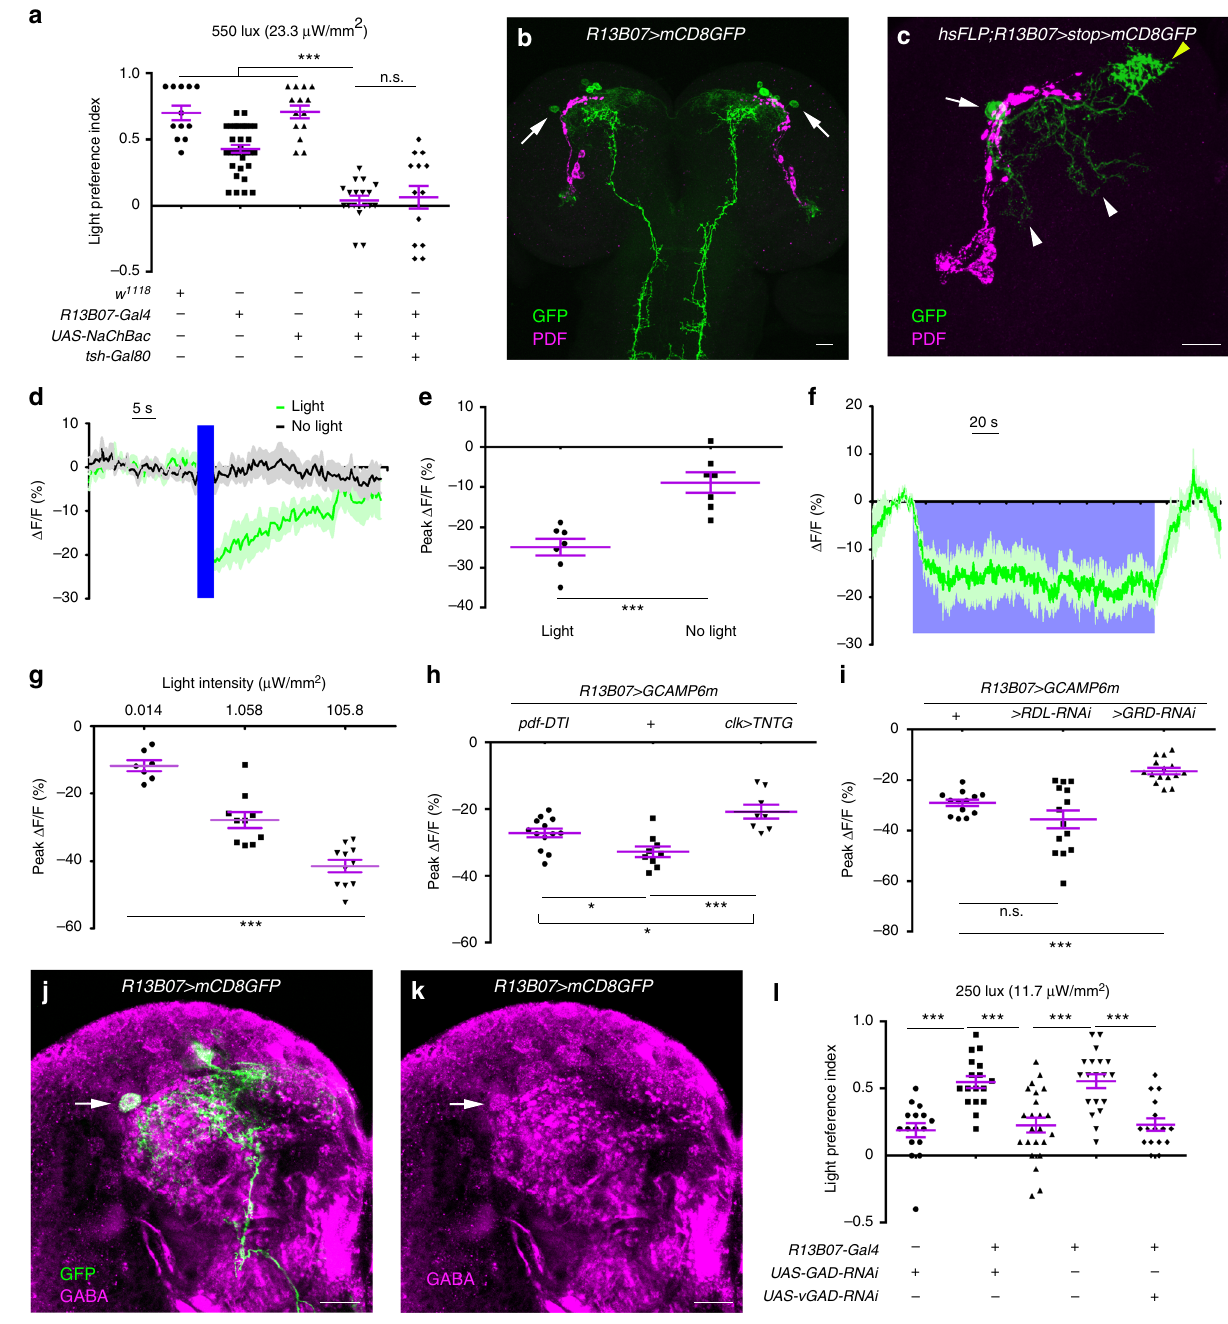
induced a robust calcium signal increase in one pair of central brain neurons labeled by R82B09-Gal4 (Fig. 2a – c), suggesting that these neurons had been subjected to tonic inhibition from the LRIN R13B07 s. These contralateral projecting neurons were then named as CLPN R82B09 s. They were also labeled by R82B09-LexA and R82B10-Gal4 (Supplementary Fig. 4a-c). The CLPN R82B09 had a small axonal arborization region in the medial contralateral brain hemisphere, a widespread dendritic region near the den- drites of the LRIN R13B07 s, and a smaller dendritic arborization area in larval SEZ (Fig. 2d, Supplementary Fig. 4d – f). The den- drites of LRIN R13B07 s were found to be overlapping with the dendrites of the CLPN R82B09 s (Fig. 2e). We then used GRASP technique to con fi rm the contact between LRIN R13B07 s and